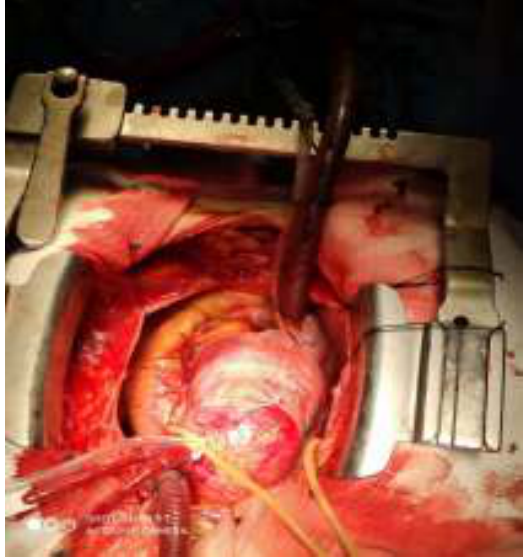
Figure 4: Reduction Aortoplasty after wrapping with Mesh around aortic